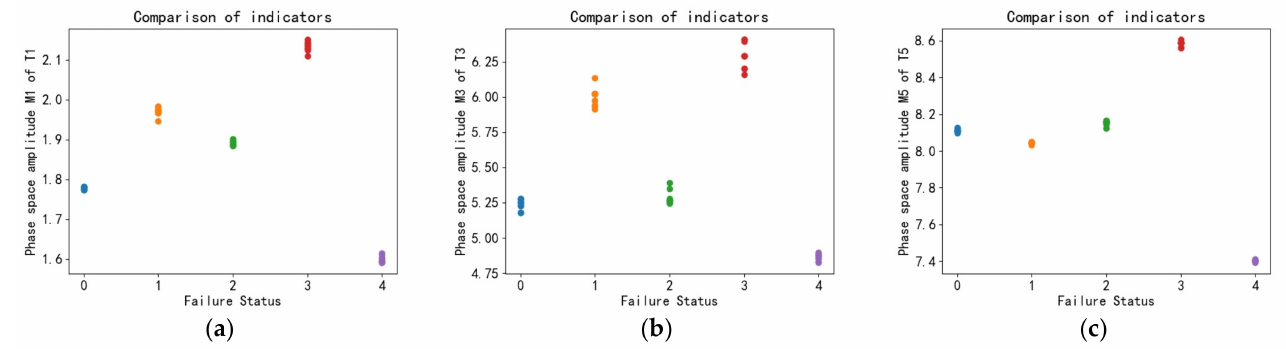
Figure 12. Distribution of local features M 1 , M 3 and M 5 for different fault phase trajectories: ( a ) am- plitude M 1 under T 1 phase space; ( b ) amplitude M 3 under T 3 phase space; ( c ) amplitude M 5 under T5 phase